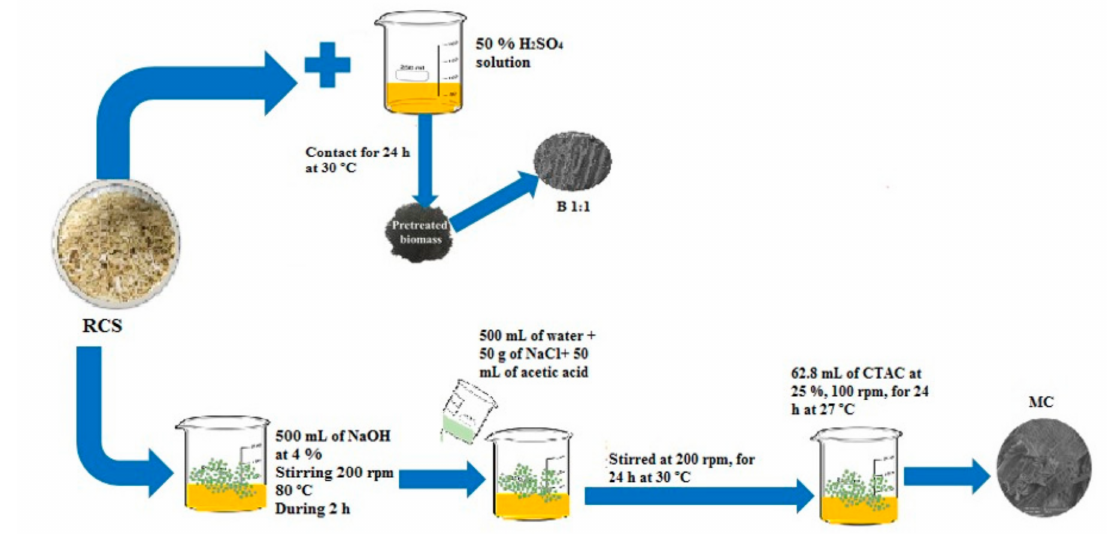
Figure 1. Mechanism of biochar modified with H 2 SO 4 at a mass/volume ratio of 1:1 (B 1:1) and modified corn (MC) bioadsorbent preparation